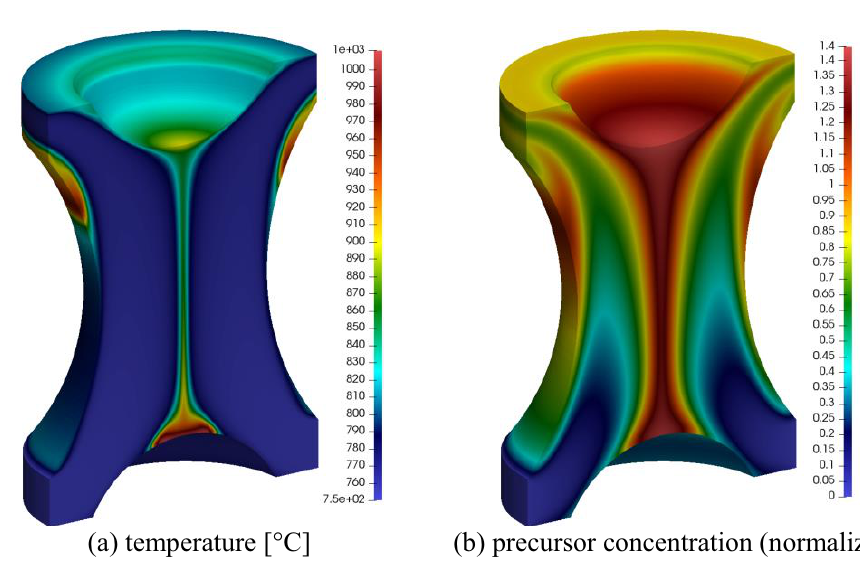
Figure 6. Steady-state distributions predicted by Nek5000 for the hourglass